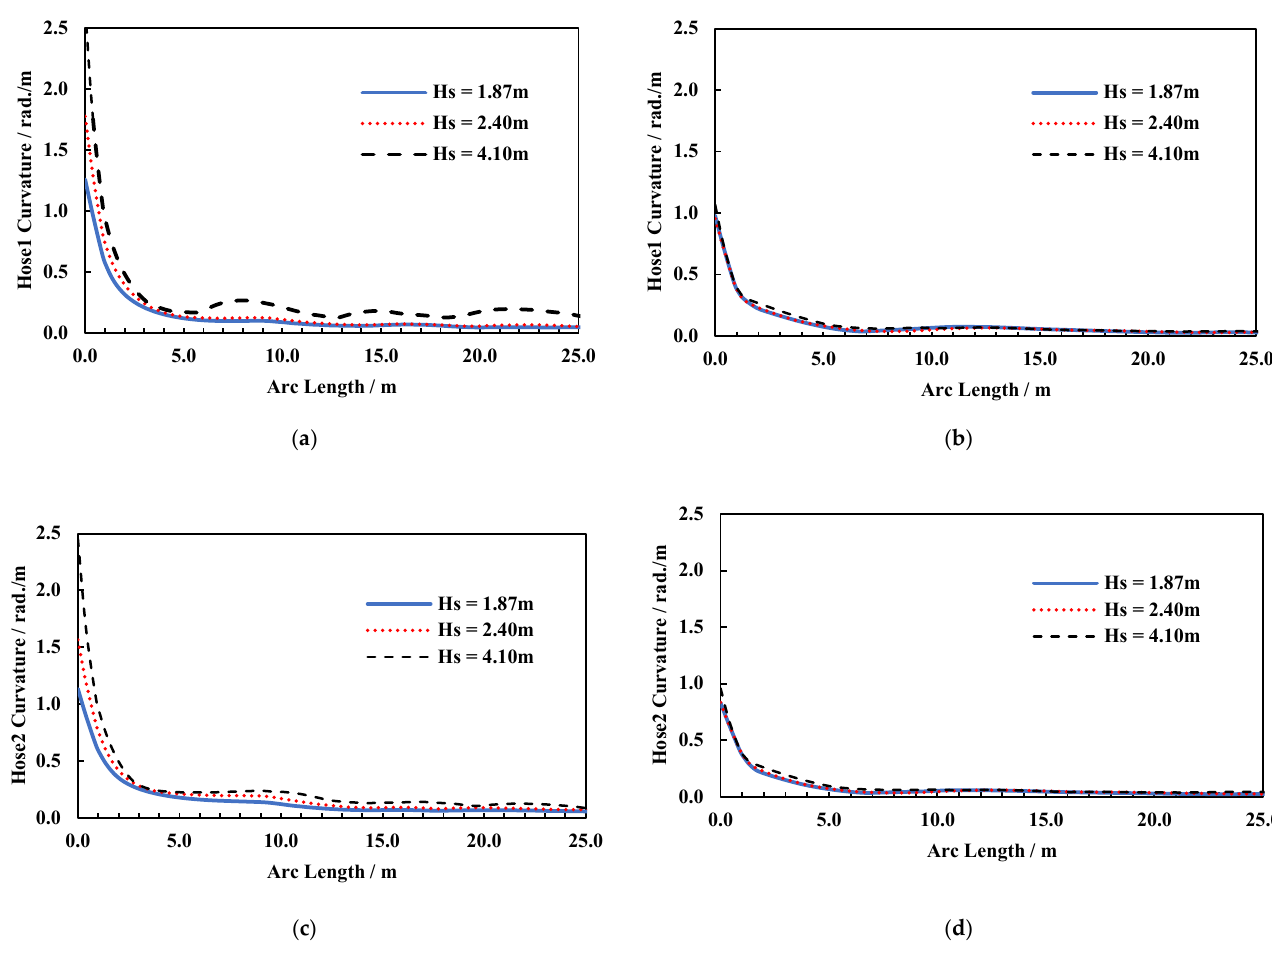
Figure 20. Influence of RAOs for different environmental cases on hose curvature. Figure ( a , c ) are when the hoses have RAO loads, while Figure ( b , d ) are when the hoses are without RAO loads for the submarine hoses in Lazy-S config. ( a ) Hose1 Curvature including hose hydrodynamic load. ( b ) Hose1 Curvature excluding hose hydrodynamic load.( c ) Hose2 Curvature including hose hydrodynamic load. ( d ) Hose2 Curvature excluding hose hydrodynamic load.